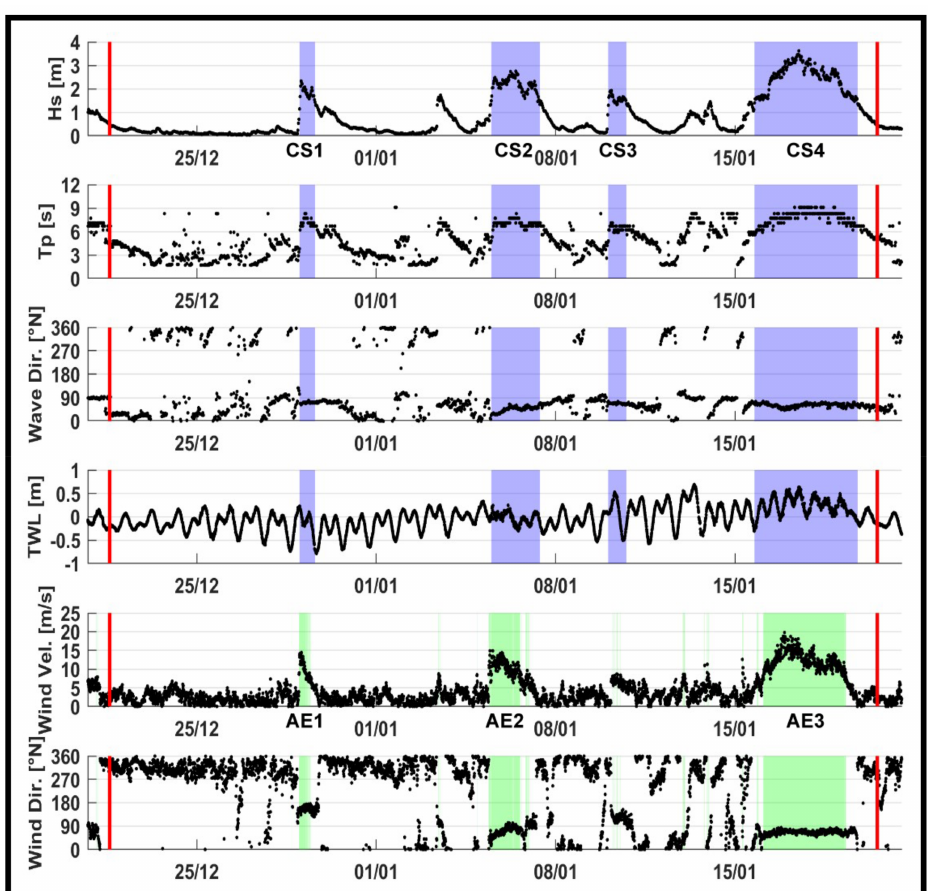
Figure 10. Significant wave height, wave period and direction (Cesenatico buoy), total water level (Porto Garibaldi tide gauge), wind velocity and direction (Porto Garibaldi meteorological station) data of the period 20 December 2016–21 January 2017. Coastal storms are highlighted by blue shadow areas; POT exceedances for wind velocity observations are highlighted by green shadow areas; the red vertical lines represent the timing of the performed